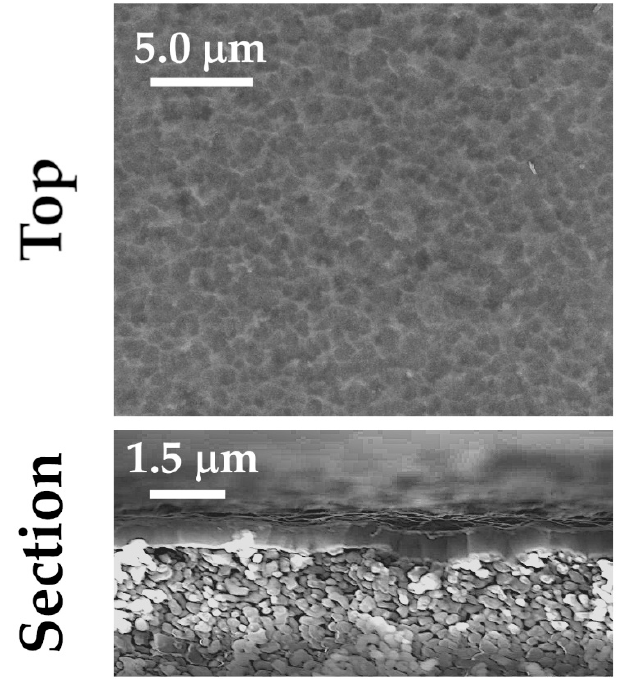
Figure 3. SEM micrographs of samples TiN4A deposited on alumina.